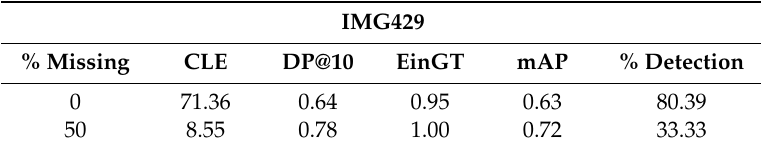
Table 2. Performance metrics for 0 and 50 percent missing pixels. JHU fire escape scenario: Video IMG428.